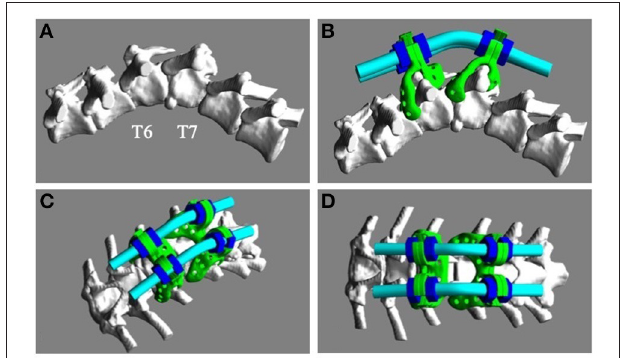
FIGURE 2 | Design of the custom-made titanium implants. (A) The deformed vertebrae were realigned to a suitable anatomical relationship using 3D modeling software. (B–D) The titanium implants consisted of spinal covers (green), fixing rods (cyan), and nuts